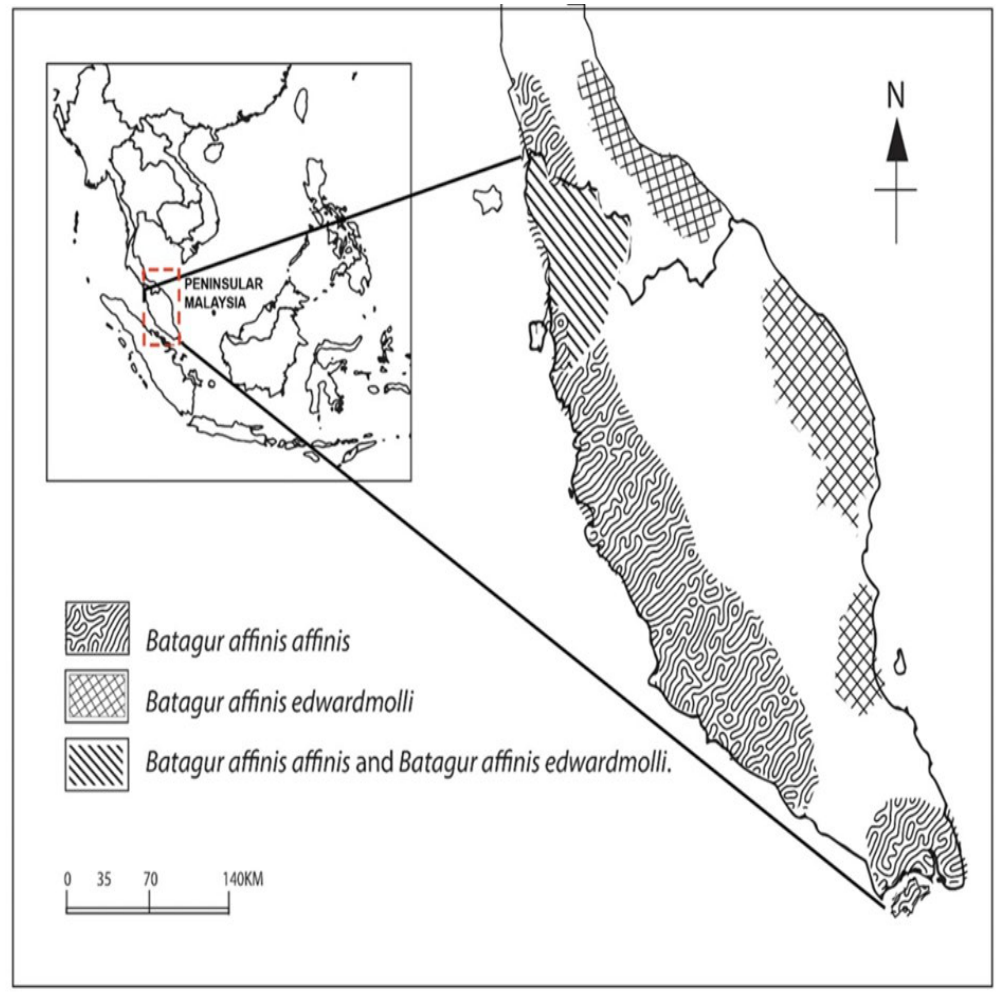
Figure 6. The distribution range of Batagur affinis affinis and Batagur affinis edwardmolli in Peninsular Malaysia.